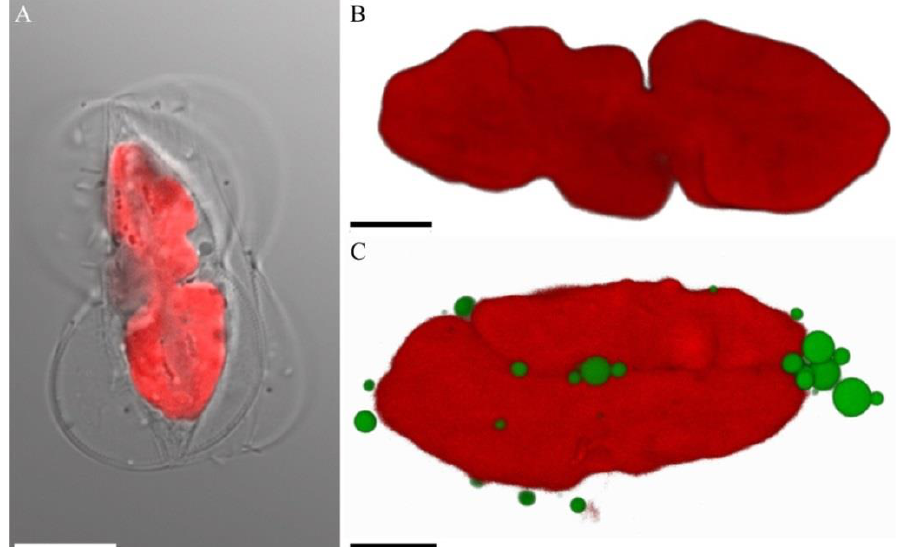
Figure 2. Chloroplasts in the cells of E . cf. paludosa of 14-day culture ( A , B ) and 62 days of cultivation ( C ); note lipid bodies stained with BODIPY 505/515 (LSCM). ( A ) — optical slice; ( B , C ) — 3D-reconstruction. Scale bars: ( A ) — 100 µm; ( B , C ) — 5 µm.